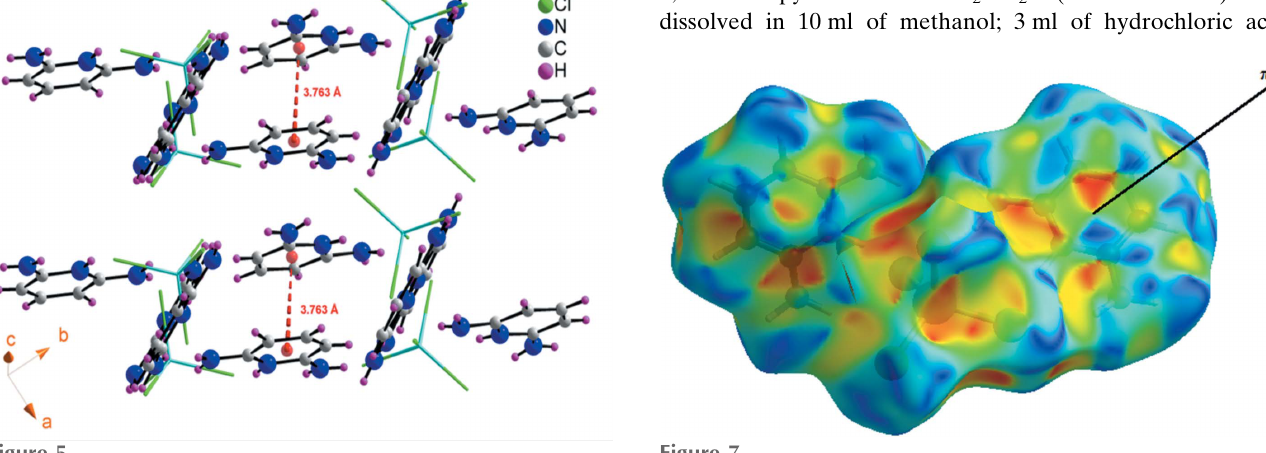
Figure 5 (cid:2) – (cid:2) stacking interactions between the neighboring aromatic organic cations in (I). The inorganic anions are shown as sticks for